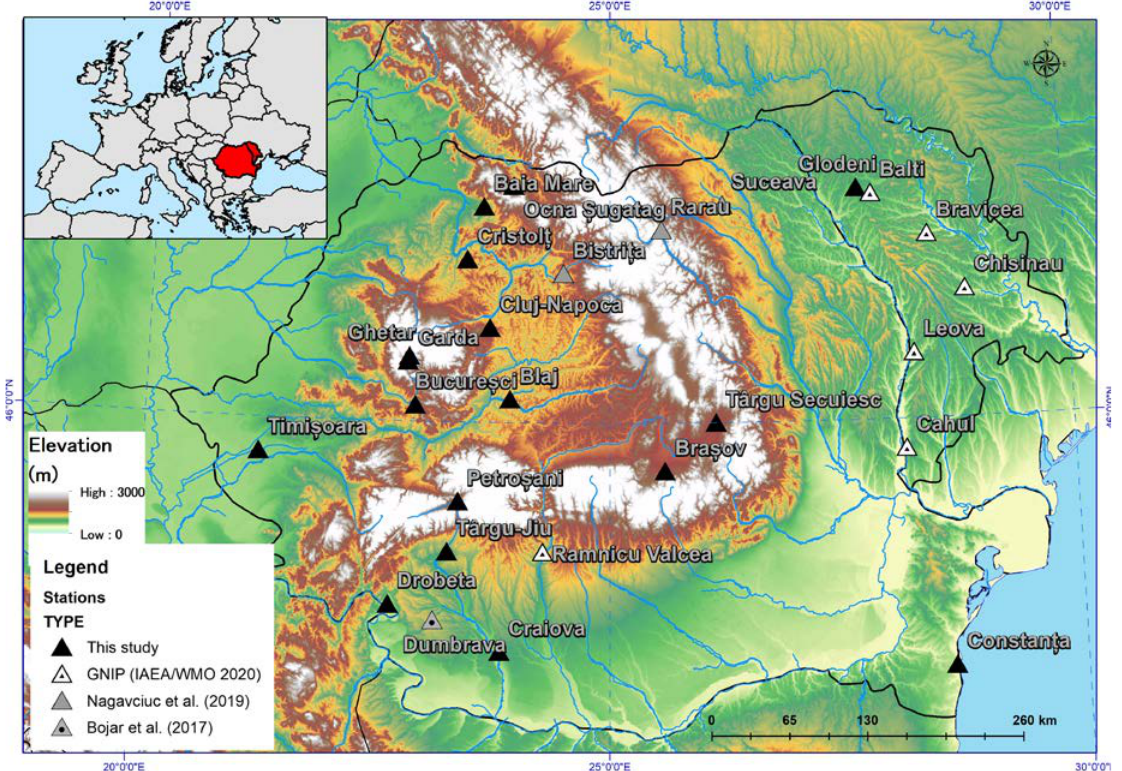
Figure 1. Map with site locations in Romania and Moldova by the source of the data; upper box: position of Romania and the Republic of Moldova in